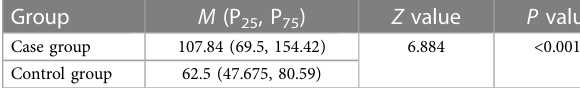
TABLE 2 Comparison between case and control groups of NLR with Wilcoxon test. Group